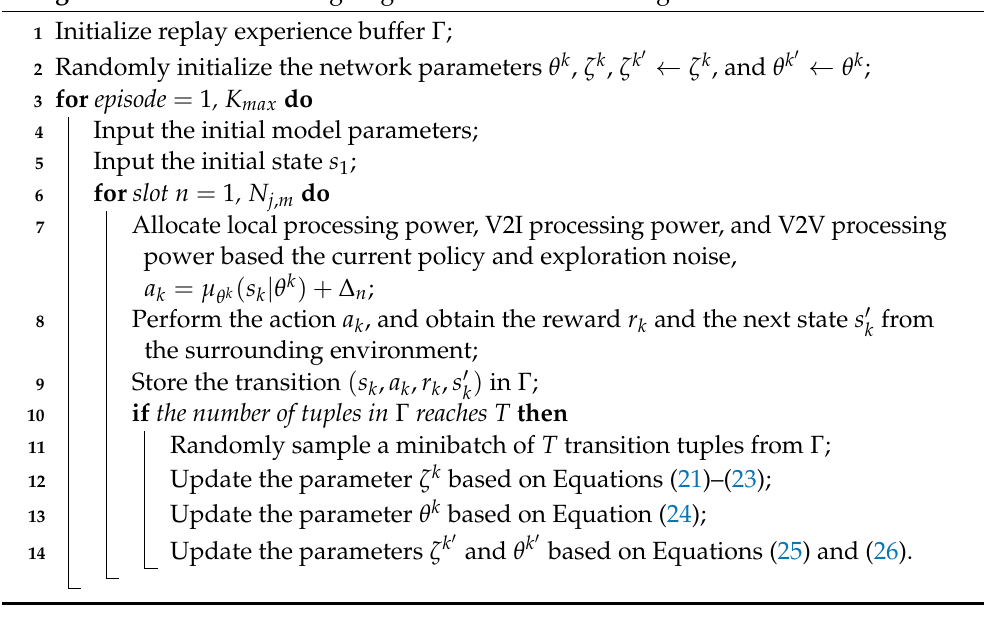
Algorithm 1: Model training stage based on the DDPG